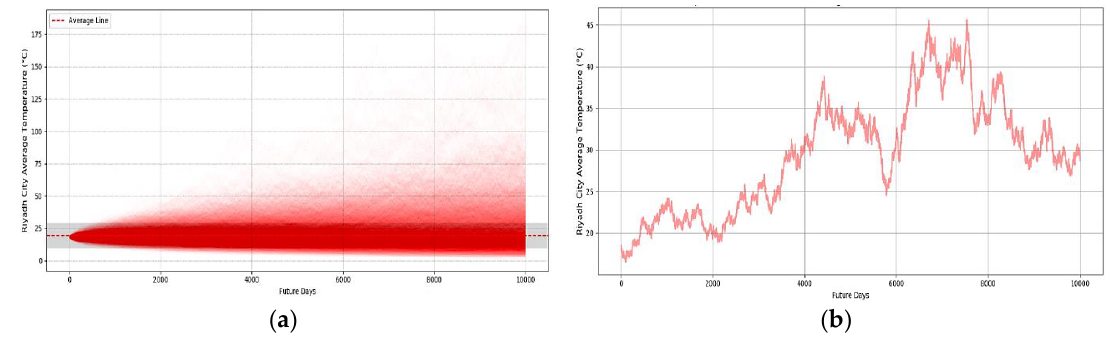
Figure 19. ( a ) Average daily temperature distributions for the central region, as predicted by MCS and BM, and ( b ) a one-day scenario for the temperature distribution prediction performance.